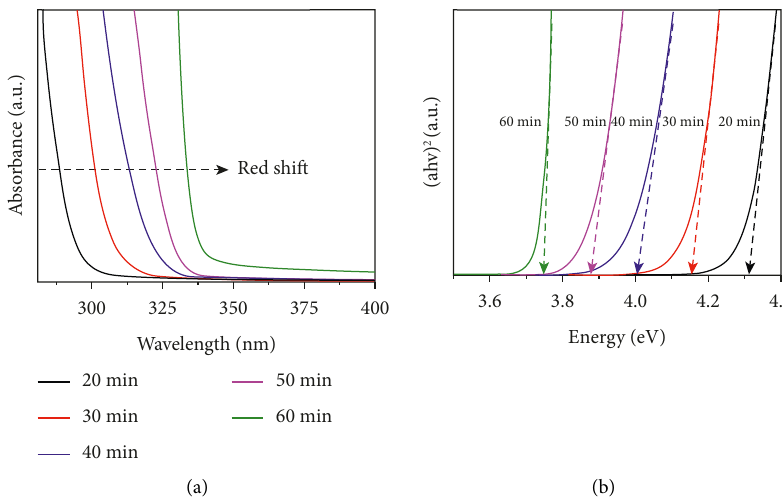
Figure 5: The effect of reaction time on (a) absorption spectra and (b) estimation of optical bandgap energy of ZnS nanoparticles synthesized by thermal decomposition of the zinc ricinoleate precursor in the oleylamine/dodecanethiol (1:1) solvent mixture at 250 ° C.